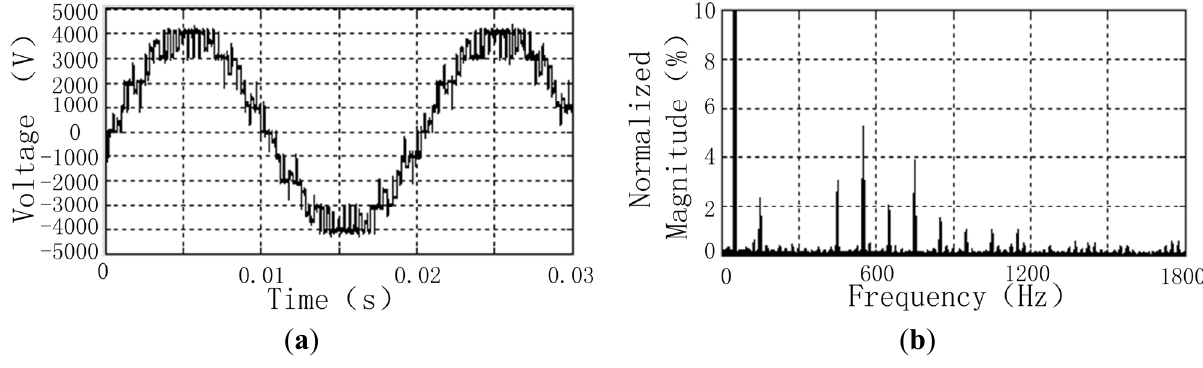
Figure 9. Result of the conventional PSCPWM when the second cell dc voltage is 395 V: ( a ) output voltage waveform; and ( b )